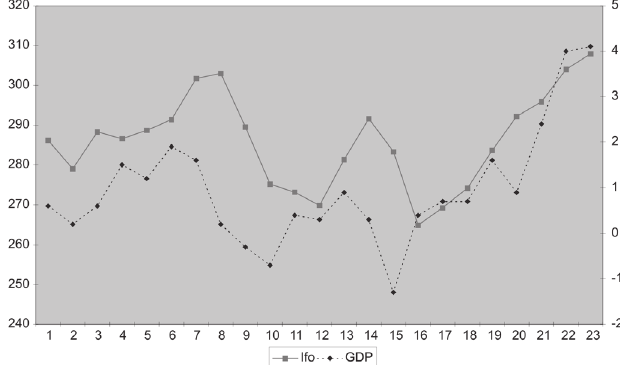
Fig 3. Ifo vs GDP,